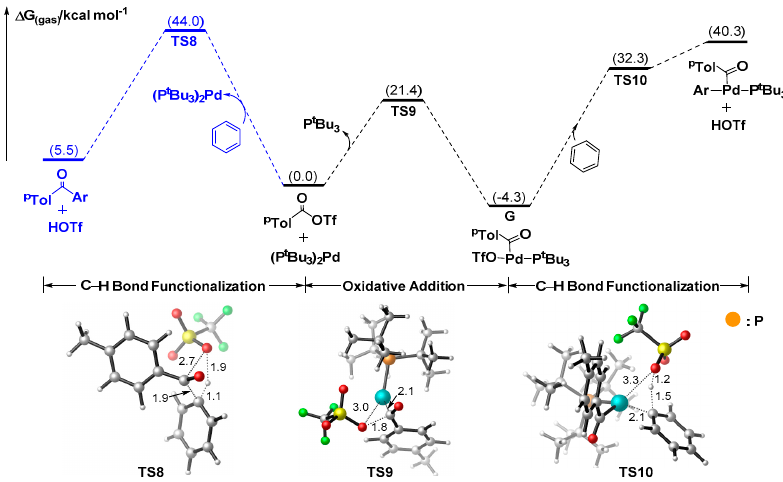
Figure 6. Calculated reaction potential energy surface of transformation between aroyl triflate or palladium-aroyl intermediate and the related C-H functionalization.